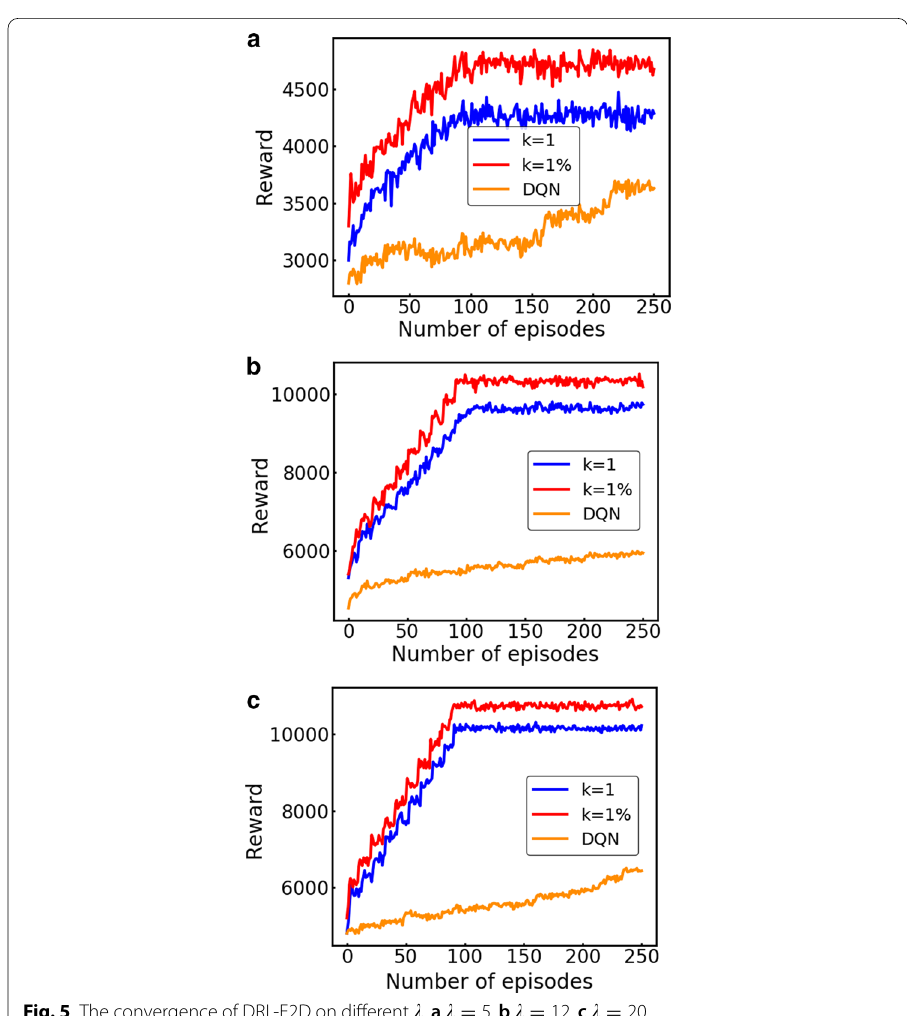
Fig. 5 The convergence of DRL-E2D on different (cid:31) . a (cid:31) = 5 . b (cid:31) = 12 . c (cid:31) =